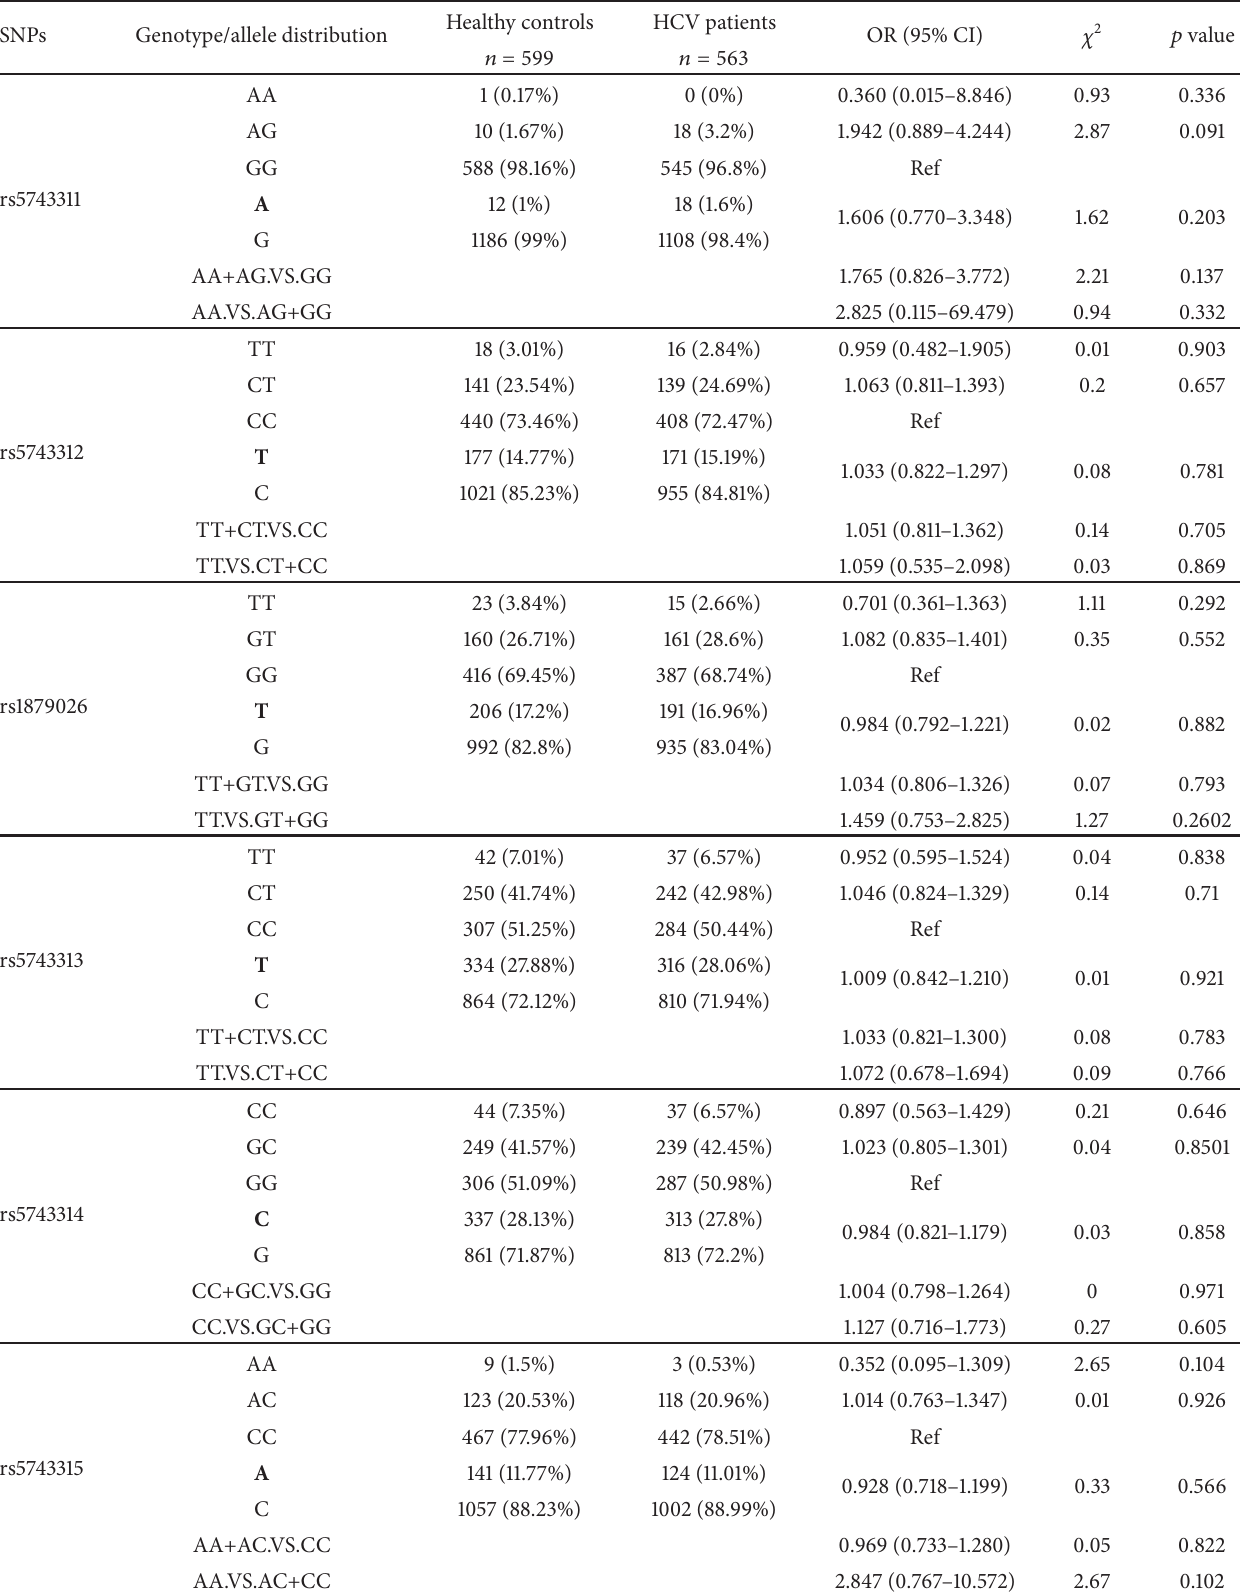
Table 3: Genotypic distribution of TLR3 gene polymorphisms when all HCV-infected patients were compared to healthy control group.